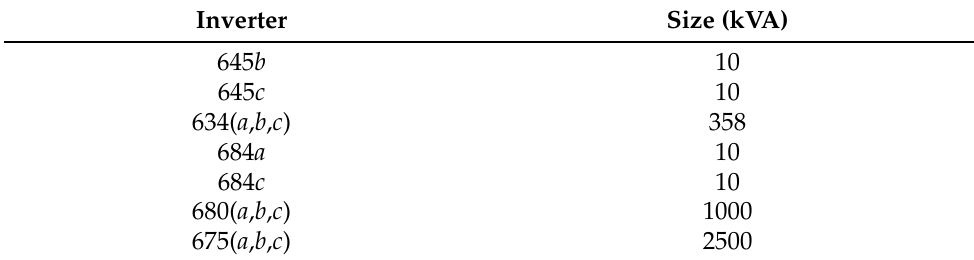
Table 2. Sizes for Inverters added to IEEE 13-Bus Test Feeder.